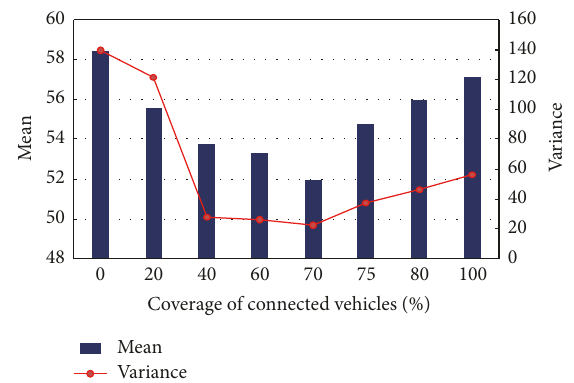
Figure 10: Travel time of in different penetration rates of connected vehicles (road_1a).